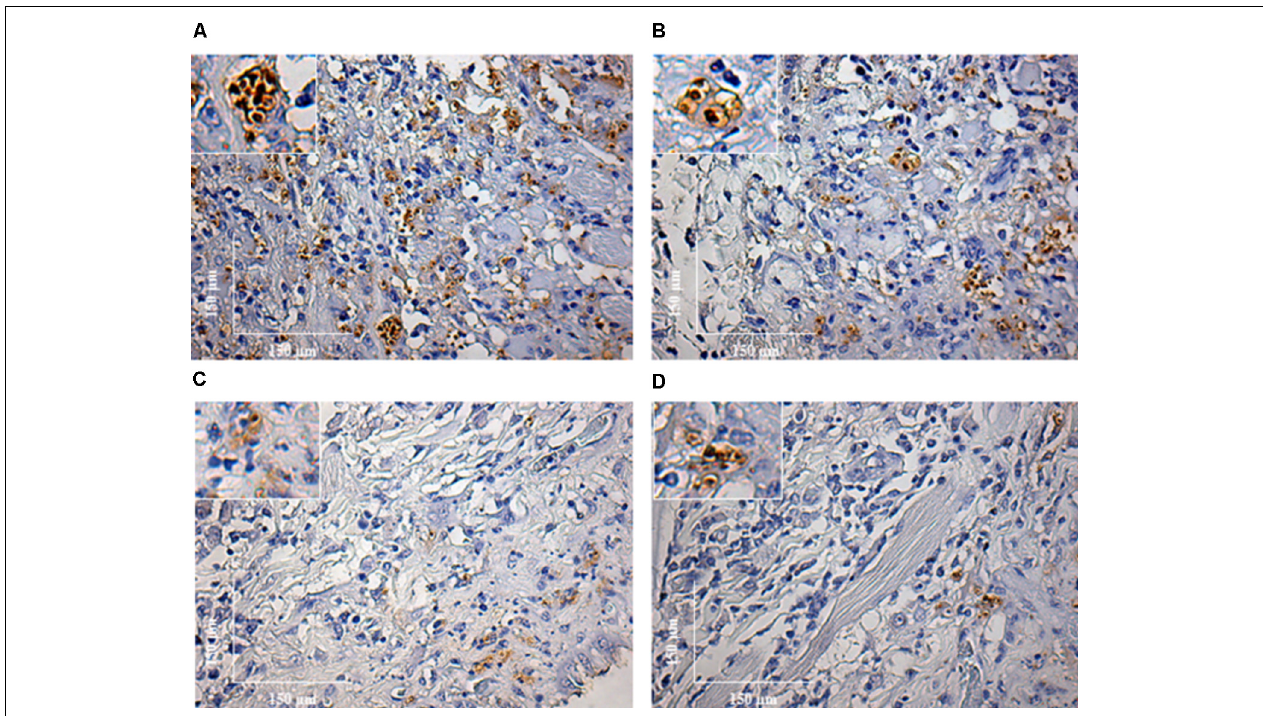
FIGURE 4 | Immunohistochemistry (IHC) of C. porcellus infected with L. enriettii (L88 and Cobaia) strains in the absence/presence of salivary gland extract (SGE). L88-infected animals exhibited an intense amastigote staining at 6 weeks PI in the absence (A) and presence (B) of SGE. Cobaia-infected animals exhibited a lower amastigote staining not only in the absence (C) but also in the presence of SGE (D) at 6 weeks PI. Amplified areas in the upper left side showing amastigotes inside